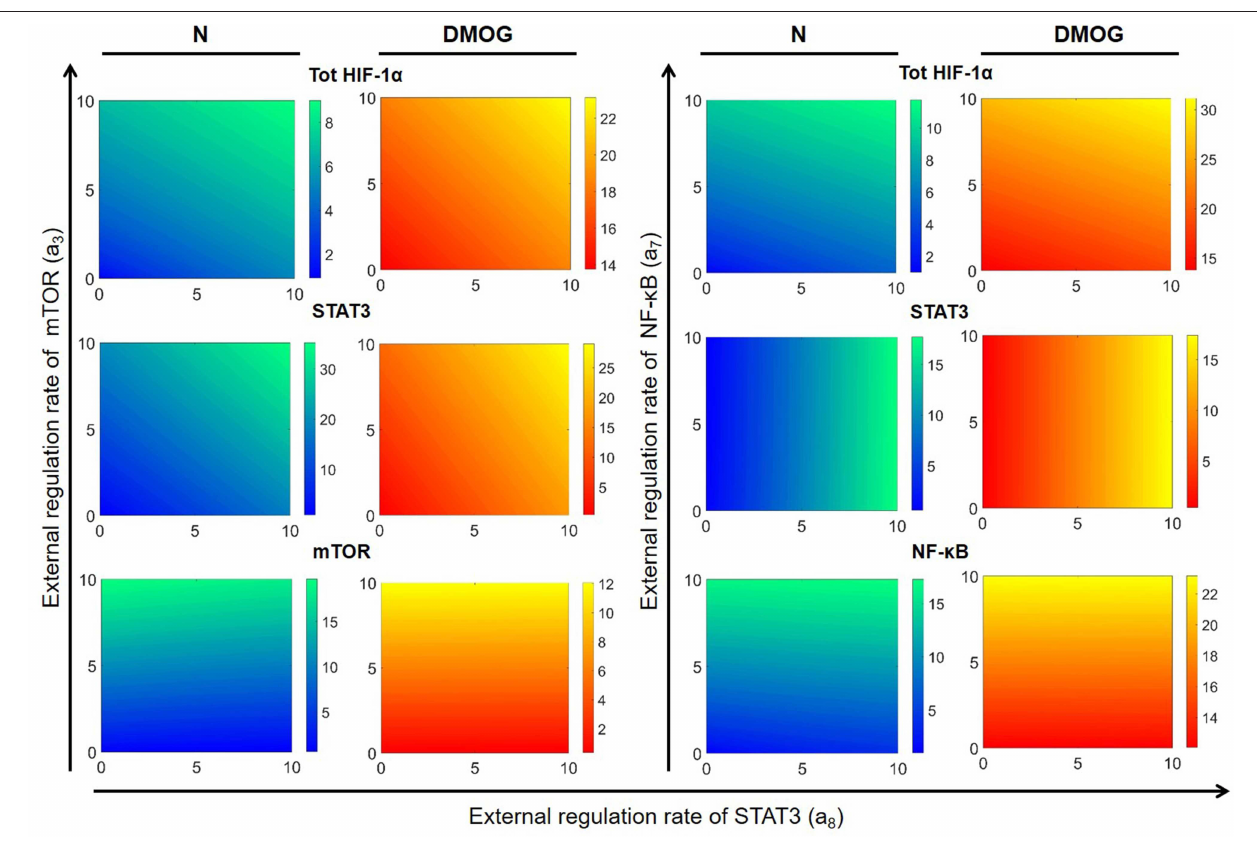
FIGURE 8 | Effects of external regulation of mTOR, NF- κ B, and STAT3 in NK cells without (N) or with DMOG. External activation rates for mTOR ( a 3 ) and STAT3 ( a 8 ) are varied in the interval [0,10] nM h − 1 and for NF- κ B ( a 7 ) in the interval [10,20] nM h − 1 . Other parameters and initial values are fixed as in Tables 1 , 2 . Steady states (100 h) of the model solutions are computed for total HIF-1 α (first row), STAT3 (second row), and mTOR or NF- κ B (third